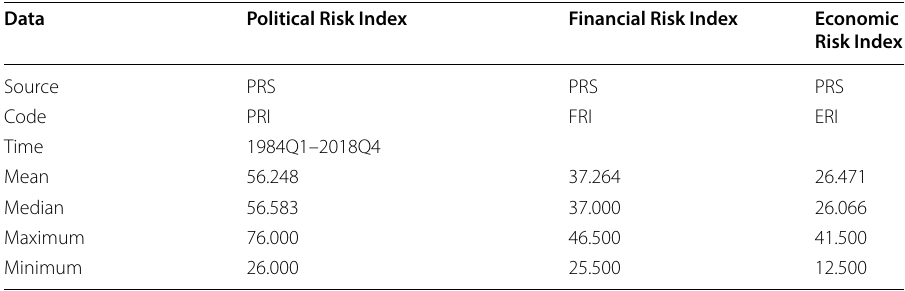
Table 2 Data and descriptive statistics